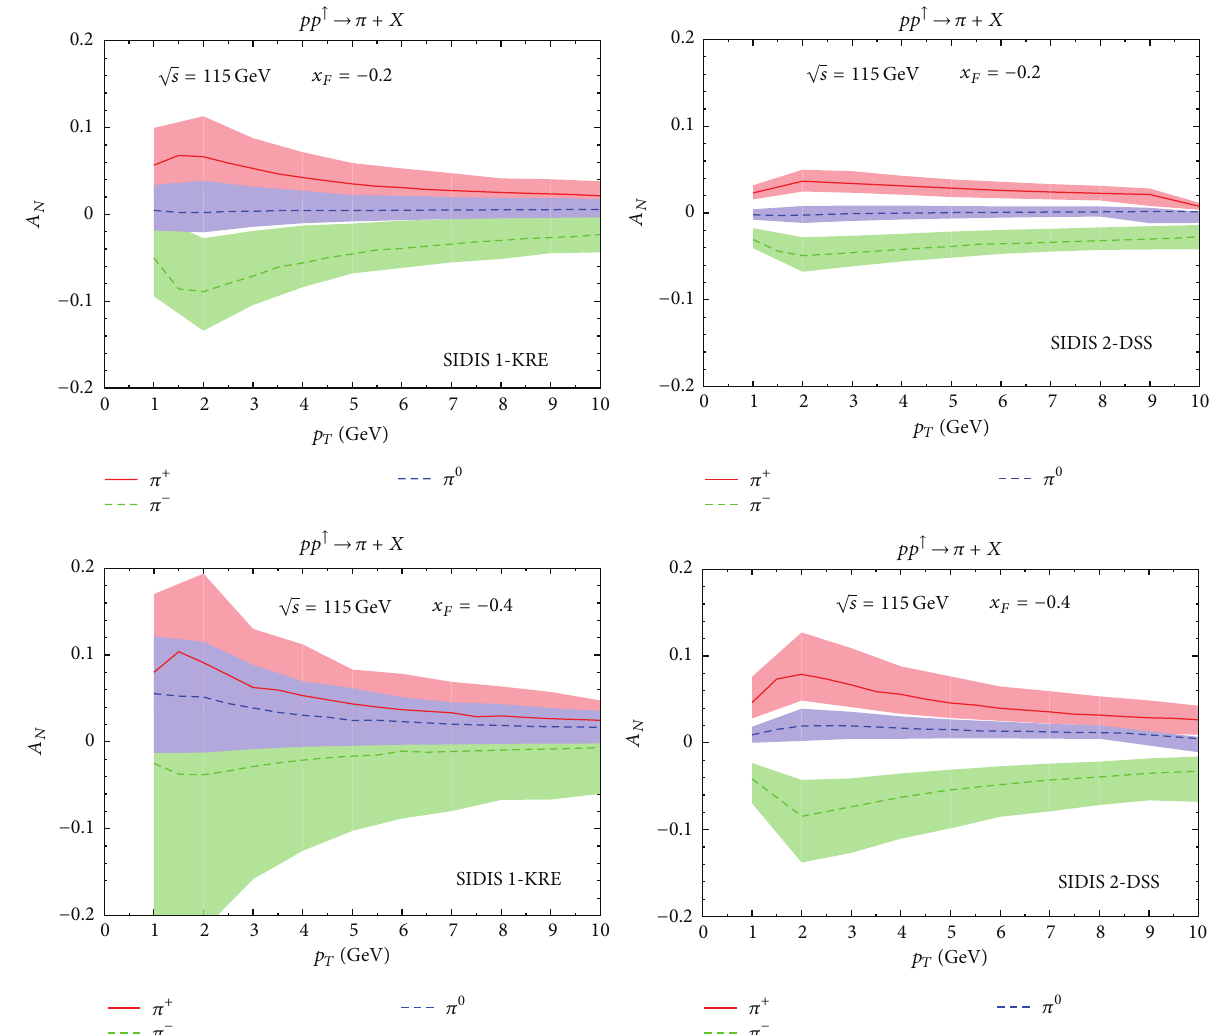
Figure 1: Our theoretical estimates for 𝐴 𝑁 versus 𝑝 𝑇 at √𝑠 = 115 GeV, 𝑥 𝐹 = − 0 . 2 (upper plots), and 𝑥 𝐹 = − 0 . 4 (lower plots) for inclusive 𝜋 ±